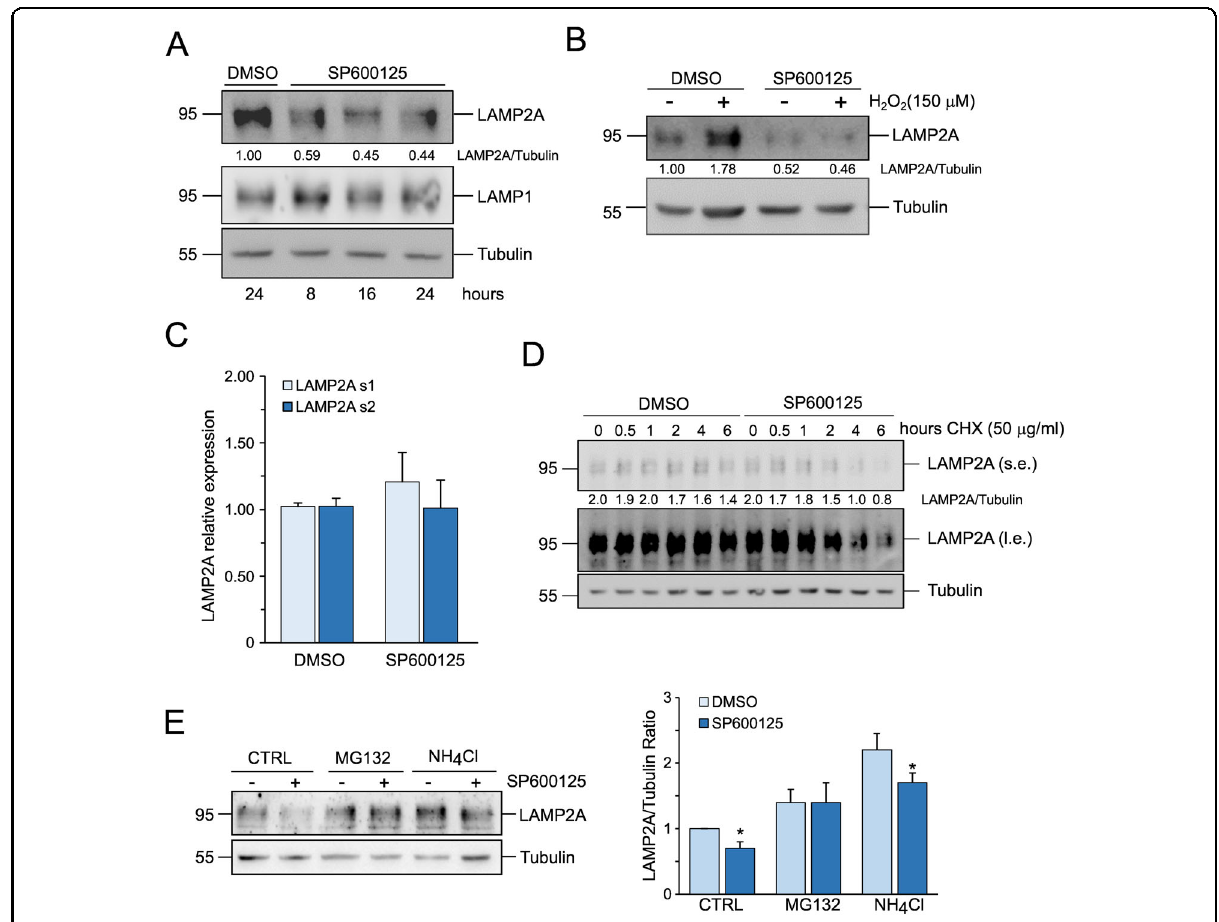
Fig. 1 JNK regulates LAMP2A stability. A Western blot analysis of LAMP2A and LAMP1 expression in Hep3B cells treated with 10 μ M SP600125 for the indicated times. B Western blot analysis of LAMP2A expression in Hep3B cells treated for 6 h with 150 μ M H 2 O 2 in the presence or absence of 10 μ M SP600125. C Real-time qPCR analysis of LAMP2A mRNA expression in Hep3B cells treated for 24 h with 10 μ M SP600125. Data are expressed as mean ± SEM of n = 3 independent experiments. Actin was used as a reference gene. D Western blot analysis of LAMP2A expression of Hep3B cells treated with 50 μ g/ml CHX for the indicated time in the presence or absence of 10 μ M SP600125. E (left panel) Western blot analysis of LAMP2A expression in Hep3B cells treated with 10 μ M SP600125 for 16 h in the presence of either 5 μ M MG132 or 20 mM NH 4 Cl. (right panel) Densitometric analysis of LAMP2A expression. Data are expressed as mean ± SEM of n = 3 independent experiments. Data were normalized to tubulin. * p < 0.05